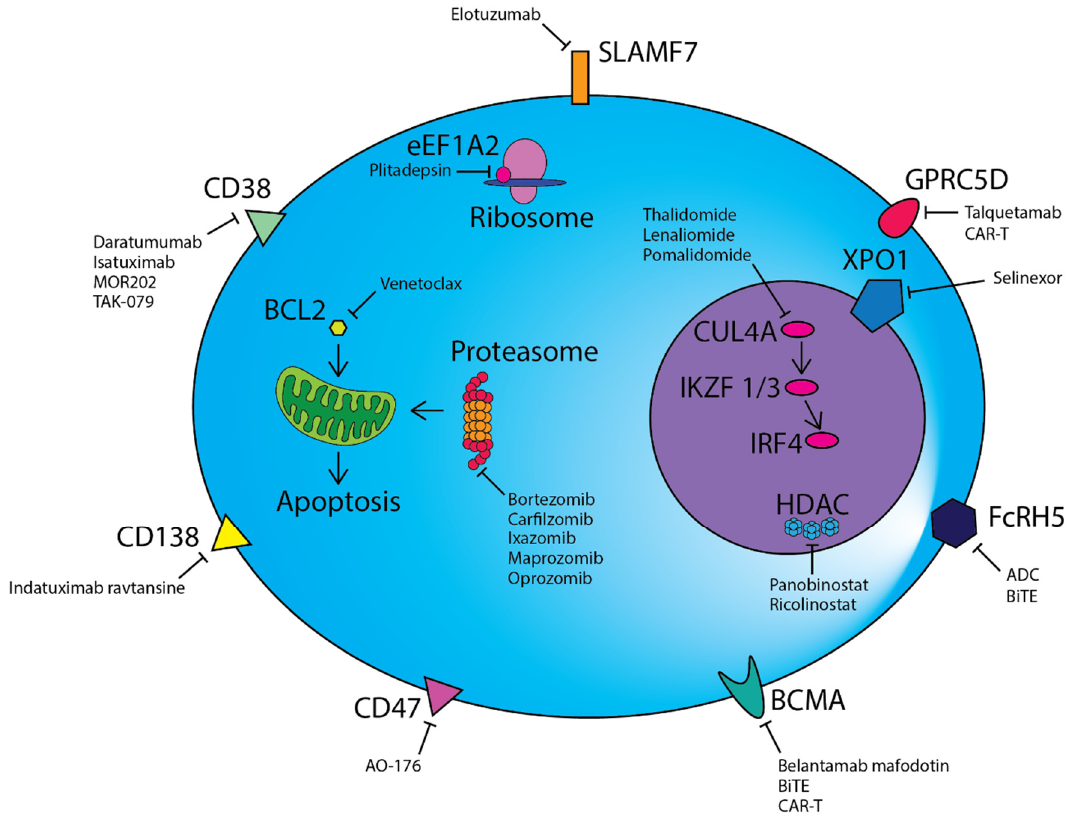
Figure 1. Therapeutic modalities in multiple myeloma.